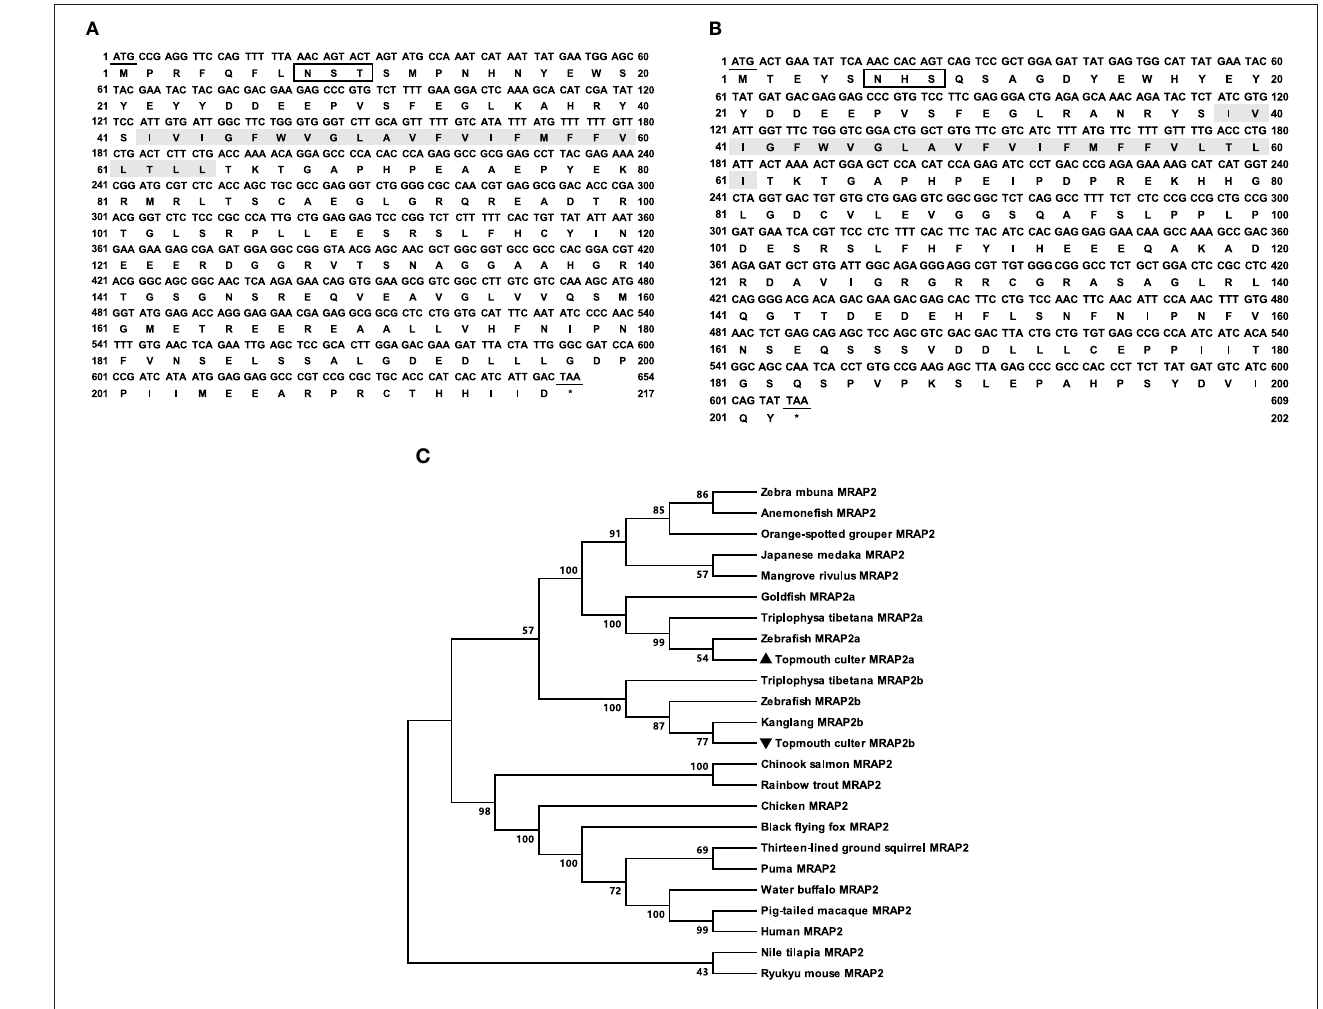
FIGURE 2 | Nucleotide and deduced amino acid sequences and phylogenetic tree of caMRAP2a and caMRAP2b. (A) Nucleotide and deduced amino acid sequences of caMRAP2a. (B) Nucleotide and deduced amino acid sequences of caMRAP2b. The positions of nucleotide and amino acid sequences are indicated on both sides. Shaded box shows putative TMD. Open boxes denote putative N -linked glycosylation sites. Underline show initiation and stop codons. Asterisk (*) indicates stop codon. (C) Phylogenetic tree of MRAP2s. The tree was constructed by the NJ method. Numbers at nodes indicate the bootstrap value, as percentages, obtained for 1,000 replicates. Black triangle dot show caMRAP2a and caMRAP2b. MRAP2s: Culter alburnus (topmouth culter, MRAP2a: MT163516, and MRAP2b: MT163517), Danio rerio (zebrafish, MRAP2a: F8W4H9.1, and MRAP2b: F8W4H9.1), Epinephelus coioides (orange-spotted grouper, QED39647.1), Oryzias latipes (Japanese medaka, XP_023809099.1), Maylandia zebra (zebra mbuna, XP_004568825.1), Amphiprion ocellaris (anemonefish, XP_023122806.1), Kryptolebias marmoratus (mangrove rivulus, XP_017267334.1), Oncorhynchus mykiss (rainbow trout, XP_021467183.1), Oreochromis niloticus (Nile